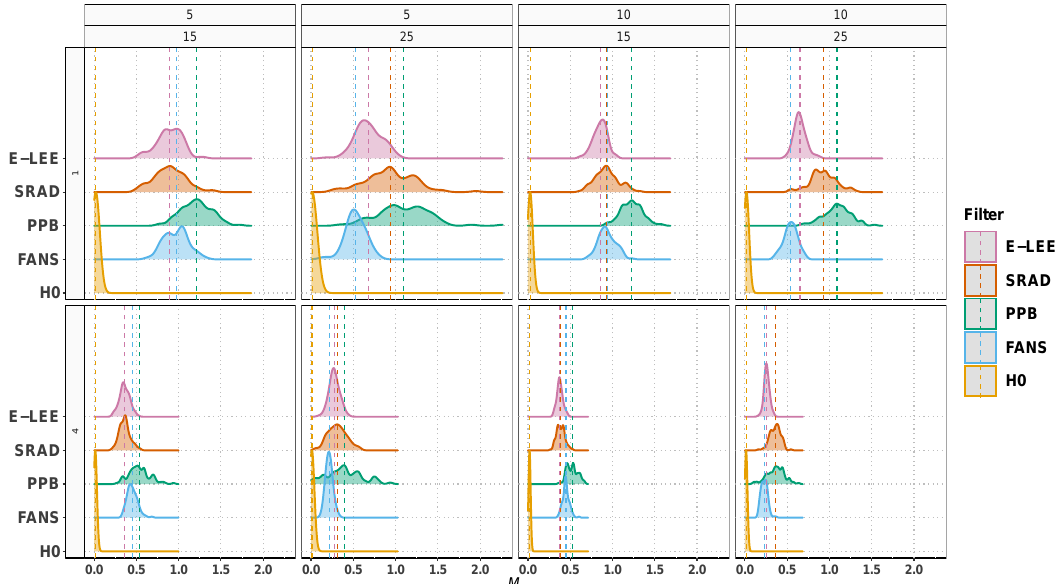
when the filters are applied to the ramp image. M under M H 0